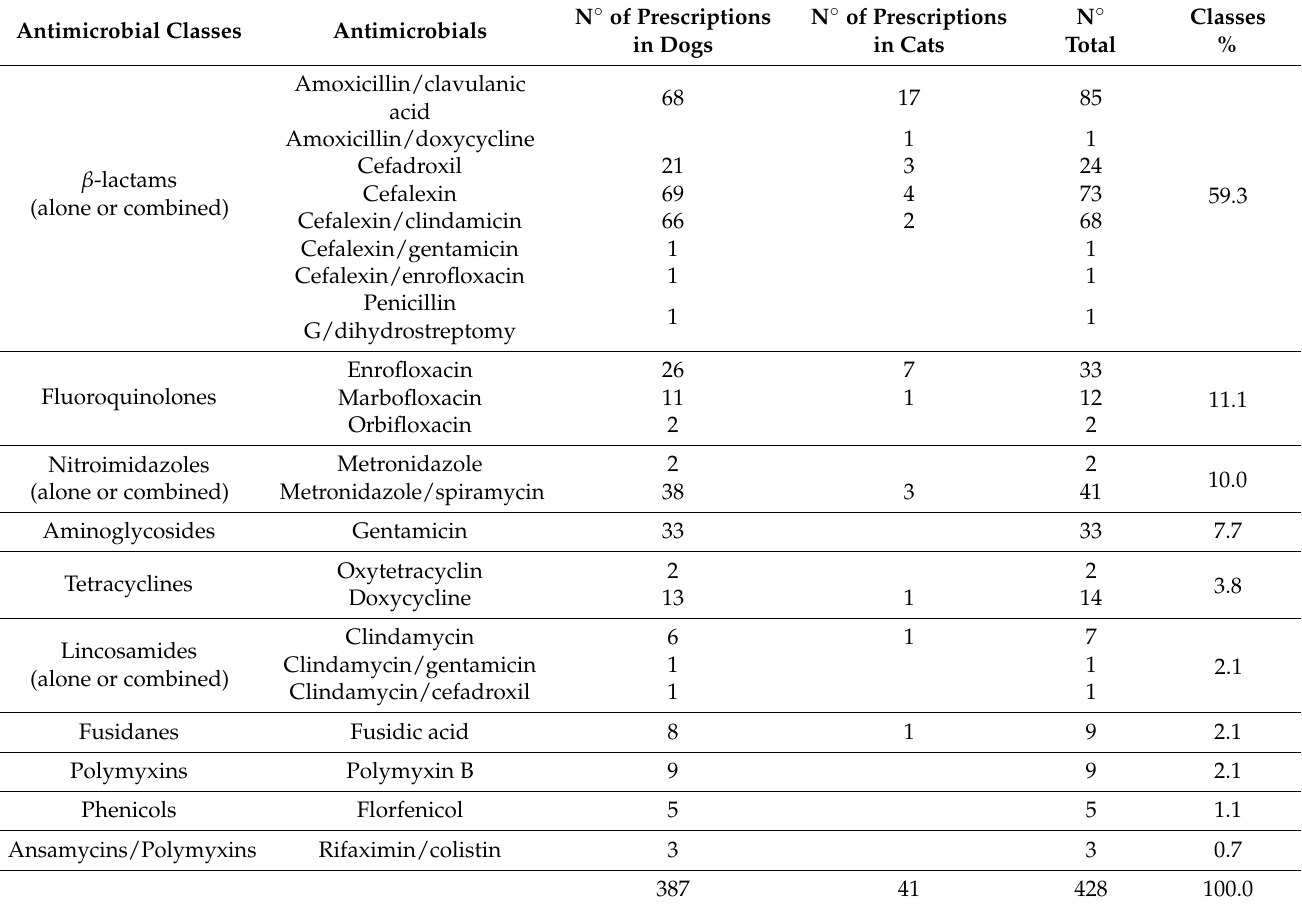
Table 2. Class of antimicrobials prescribed in dogs and cats after the mandatory use of VEP (from April 2019 to March 2020). Antimicrobial